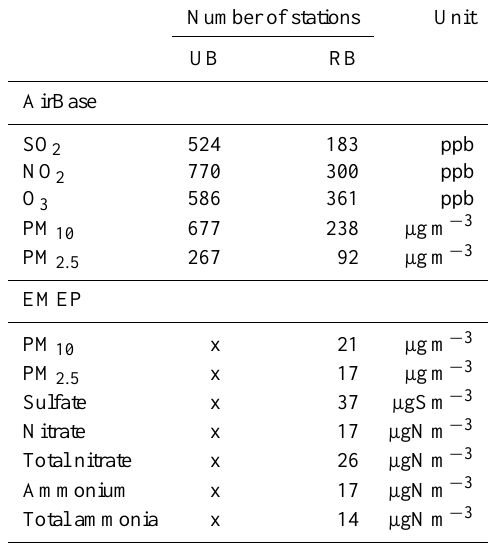
ditions in summer also favour accumulation and recirculation of pollutants in the Mediterranean basin.